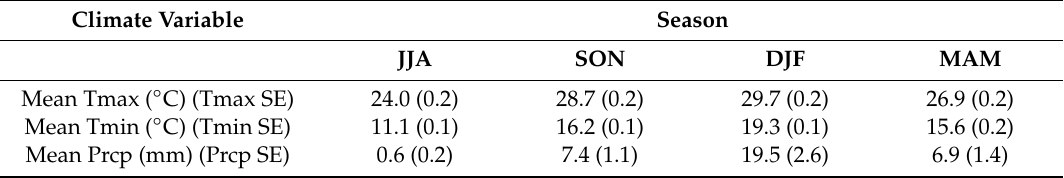
Table 1. Mean and standard error (SE) of weekly precipitation and temperature by season for 2002 to 2016 for the study